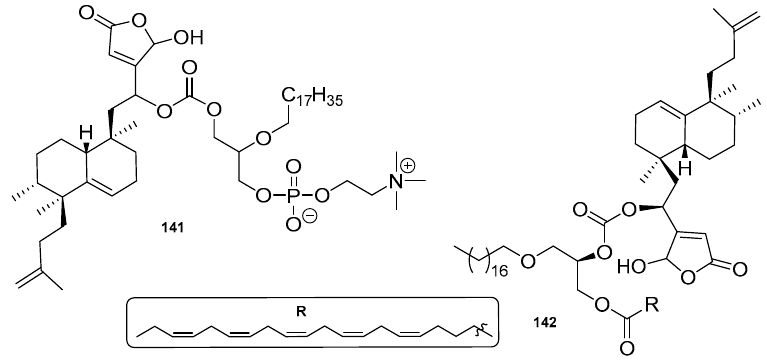
Figure 8. Synthesized sesterterpenolides hybrid compounds.